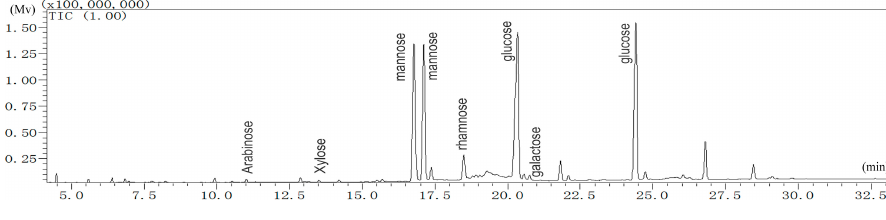
Figure 1. GC-MS analysis of LBP.